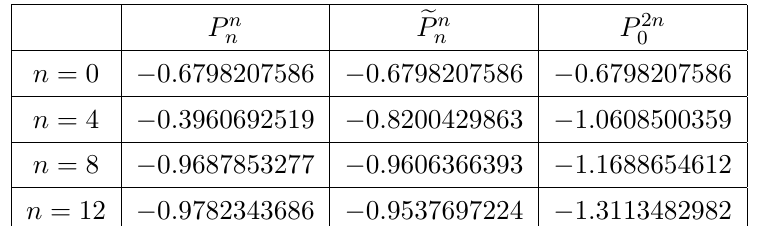
Table 2 . The Pad(cid:19)e and Pad(cid:19)e-Borel approximations for the normalized value of the vacuum energy (cid:0) (cid:1) ~ E ( z ) = (cid:25) 2 z 2 tr[ z L 0 ^(cid:8) Q B z L 0 ^(cid:8) ] evaluated at z = 1. The second column shows the P n 3 approximation. The third column shows the corresponding e P n last column, P 2 n represents a trivial approximation, a naively summed 0